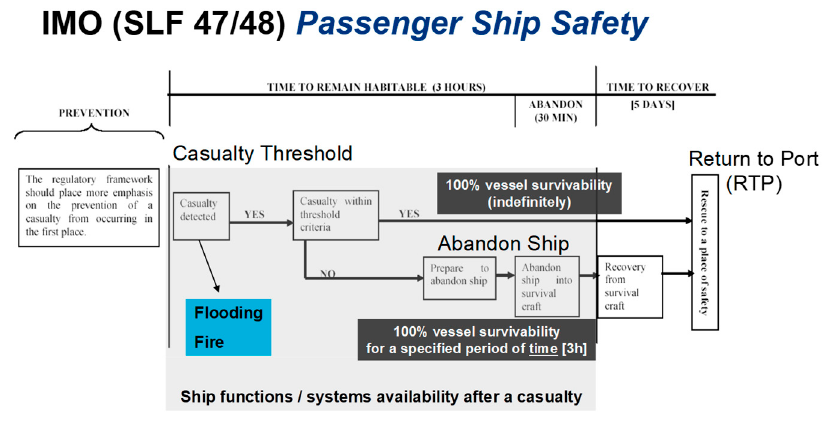
Figure 3. The IMO framework for passenger ship safety.